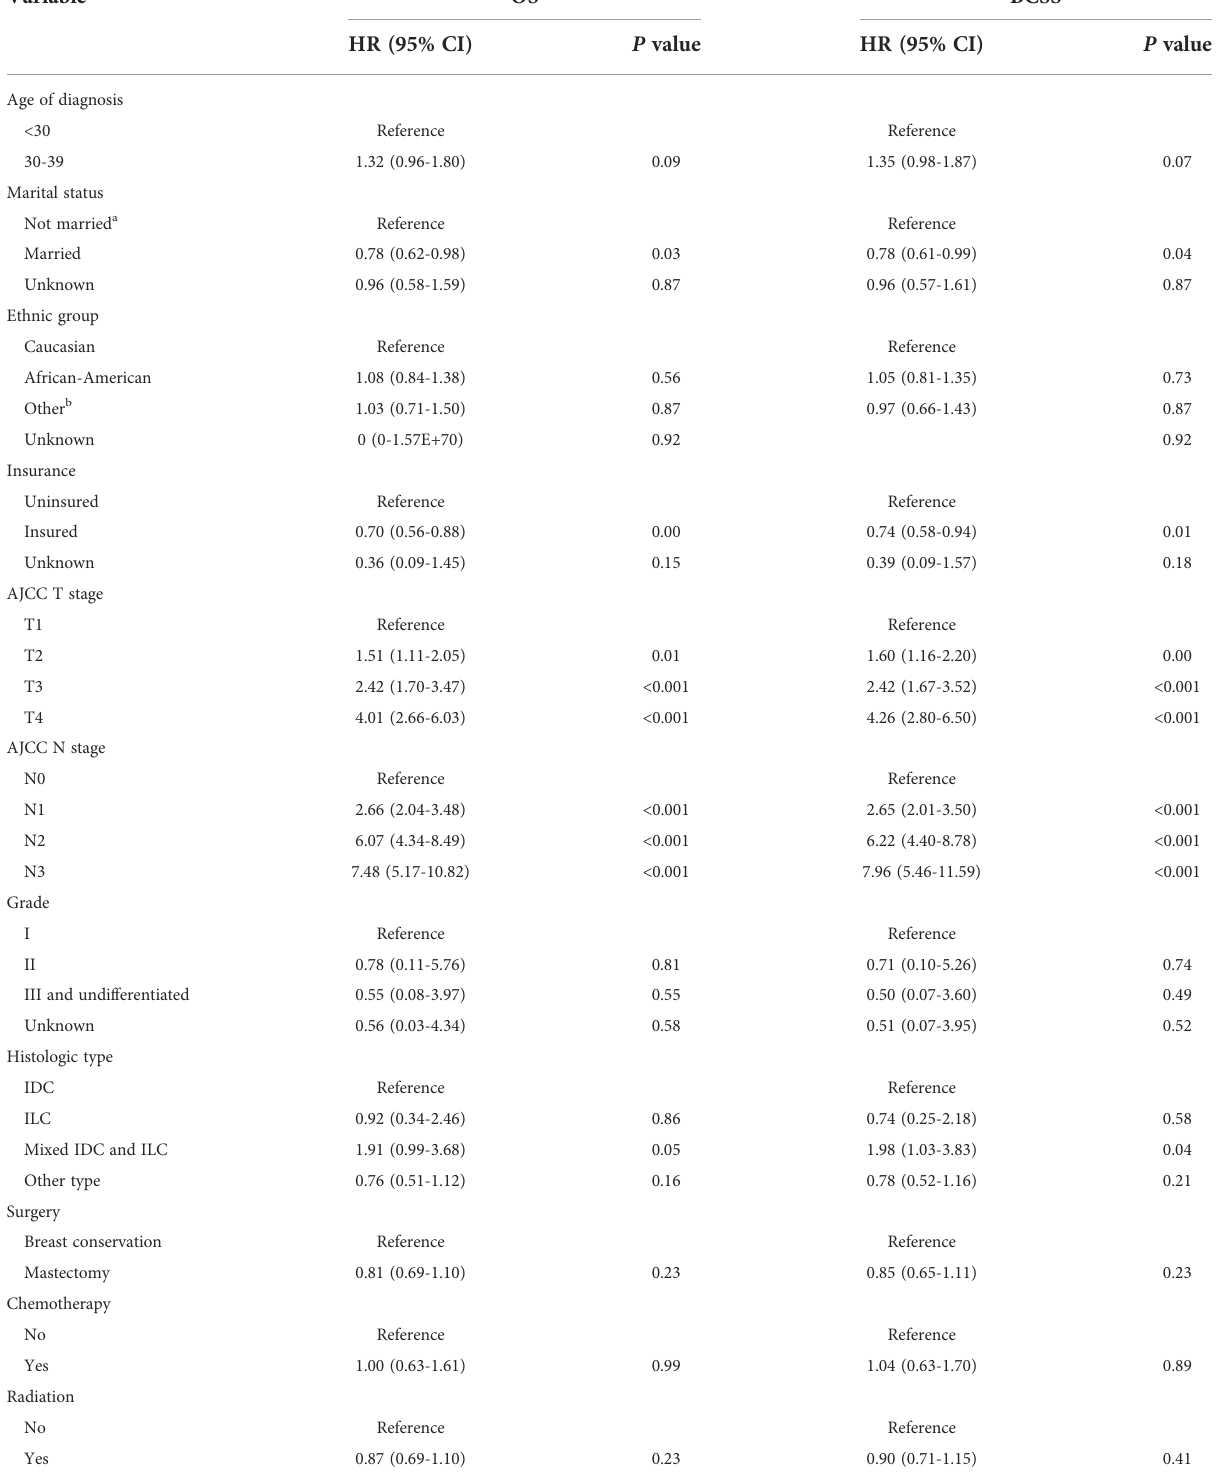
TABLE 2 Multivariable analysis of factors potentially predictive of overall survival and breast cancer-speci fi c